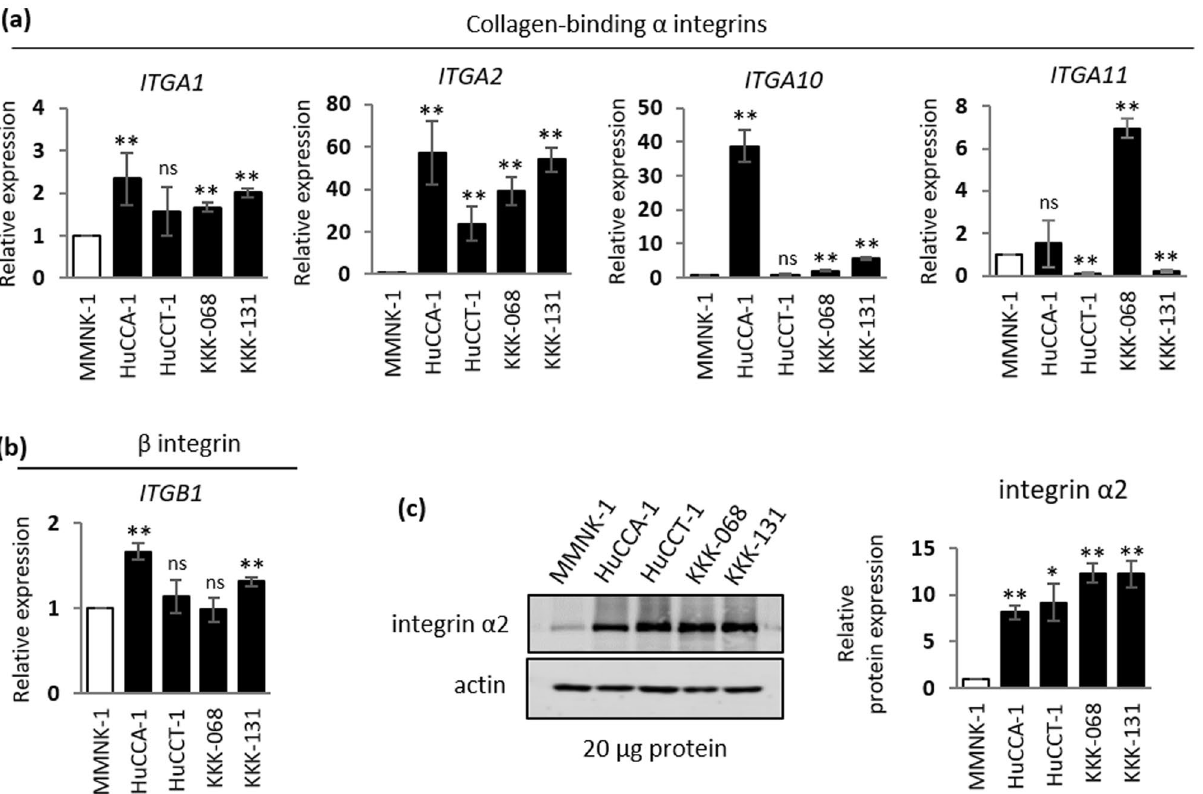
Figure 2. Intrahepatic cholangiocarcinoma cells display high basal integrin α2 expression. Relative gene expression of ( a ) collagen-binding integrin α subunits: ITGA1, ITGA2, ITGA10 and ITGA11 , and their partner ( b ) integrin β subunit, ITGB1, from a non-cancerous MMNK-1 cholangiocyte cell line or four iCCA cell lines: HuCCA-1, HuCCT-1, KKK-068 and KKK-131. ( c ) Immunoblot analysis of integrin α2 protein expression in MMNK-1 cells and four iCCA cell lines, actin serves as an internal control. Quantification from three independent experiments are shown on the right panel; white bars, a non-cancerous cell line; black bars, cancerous cell lines. All data are expressed as the mean ± SD from at least three independent experiments. The Student’s t-test was used to calculate p -value, compared with MMNK-1 control. ns, not significant; * p < 0.05; ** p < 0.01.